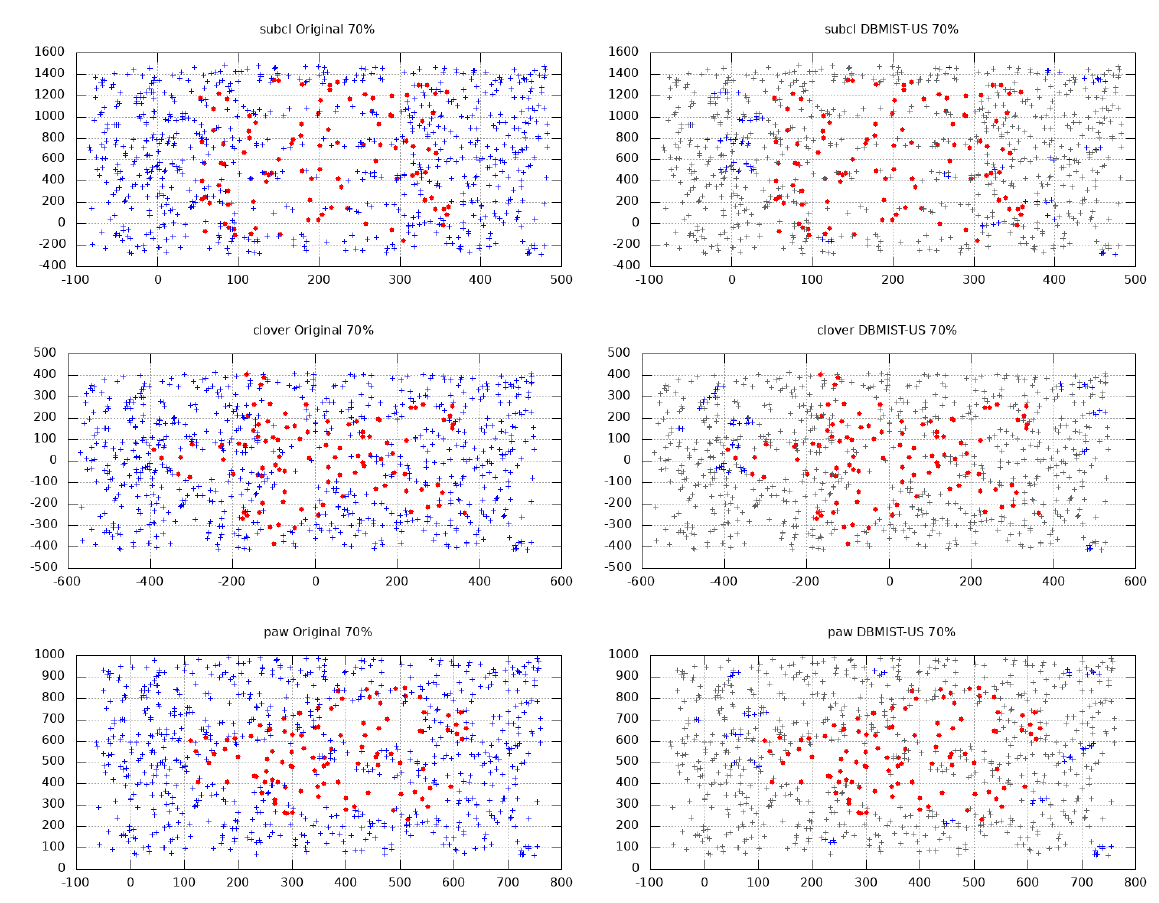
Figure 7. Scatter plots of the synthetic data sets (70% of noise) for the non-preprocessed sets and the sets yielded by DBMIST-US (points in gray color correspond to the instances that were